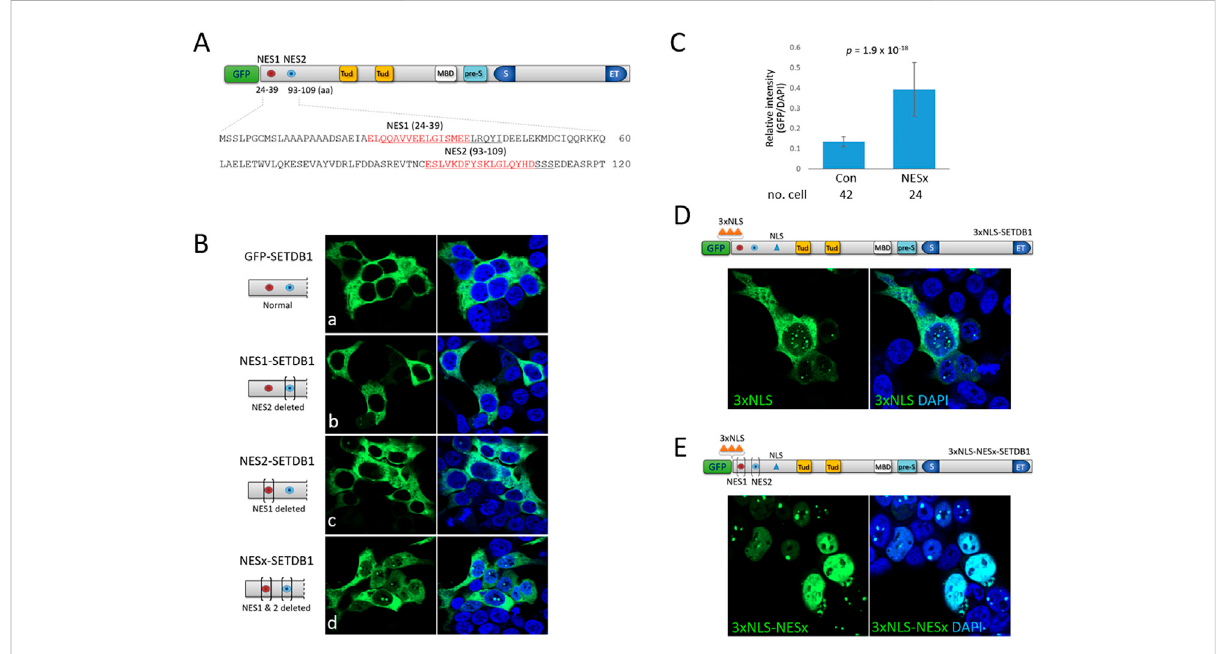
FIGURE 1 EffectofN-terminalnuclearexportandlocalizationsignalsonsubcellularlocalization ofSETDB1 (A) SchematicoftheSETDB1proteinstructure showing two nuclear export signal motifs, NES1 and NES2, in the N-terminus. Individual NES1 and NES2 amino-acid sequences (red) in the N-terminus were deleted (underlined) using CRISPR/Cas9 technology to generate NES1- (NES2 deleted), NES2- (NES1 deleted), and NESx-SETDB1 (both deleted) constructs. Tud, Tudor domain; MBD, methyl-CpG-binding domain; pre-S, pre-SET domain; S and ET, bifurcated SET domain. (B) Overexpression of GFP-SETDB1 variants in 293T cells. Brackets in the schematic denote deletions in the indicated NES domains. (C) Relative signalintensity ofnuclearGFPtoDAPIineitherGFP-SETDB1 (control) orNESx-SETDB1-expressing293Tcells. Theintensity wasmeasuredusingthe histogram tool in Zen software (blue edition v3.4) from Carl Zeiss Microscopy GMBH. The number of cells examined is indicated below. Statistical differences (two-sample t -tests) are shown. (D) Effect of three copies of NLS (3xNLS, orange-colored triangles) in the N-terminus on subcellular localization of SETDB1. The resulting 3xNLS-SETDB1 construct was expressed in 293T cells. (E) The movement of the NES-deleted (NESx) 3xNLS- SETDB1 construct (3xNLS-NESx-SETDB1) in 293T cells. Images were obtained using a confocal microscopy (Carl Zeiss